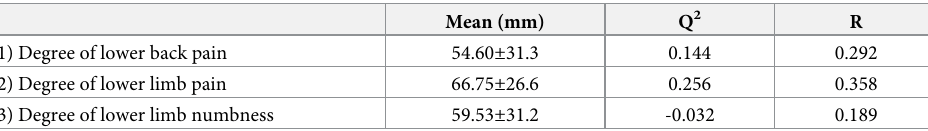
Table 1. Result of the PLS regression